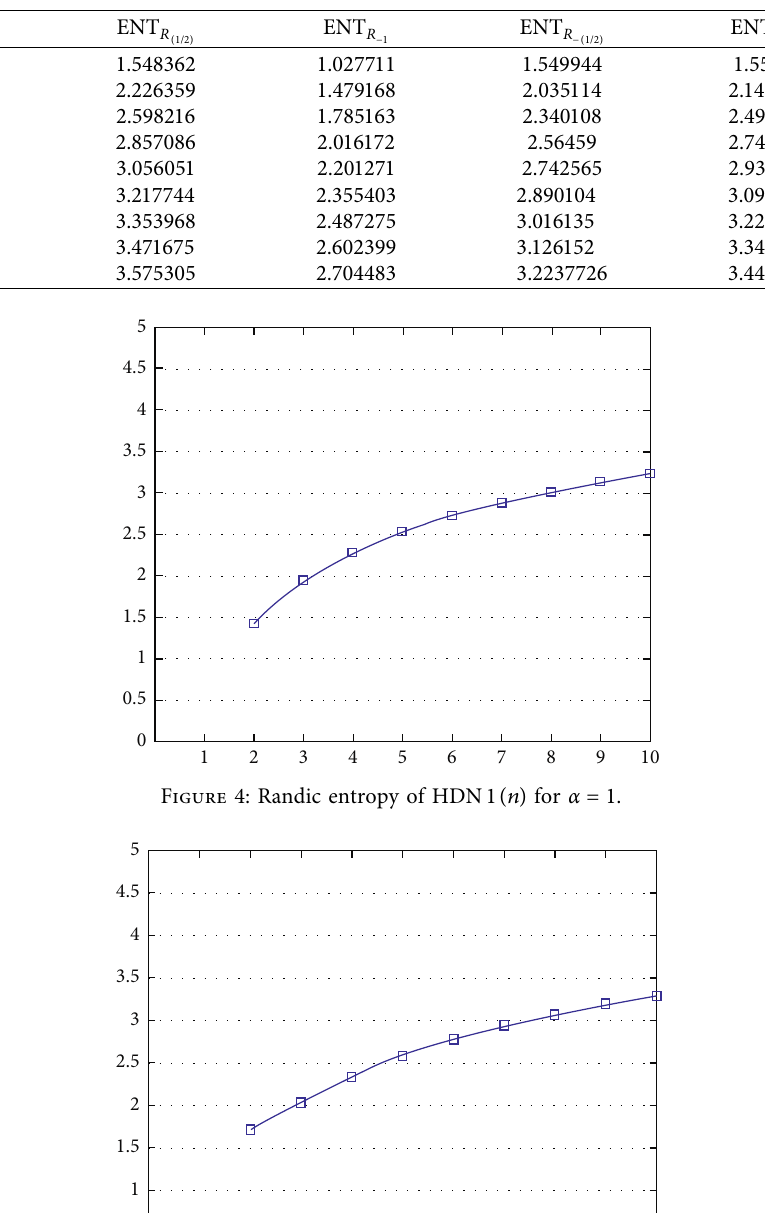
Table 6: Comparison table of entropies for HDN 2 ( n ) .